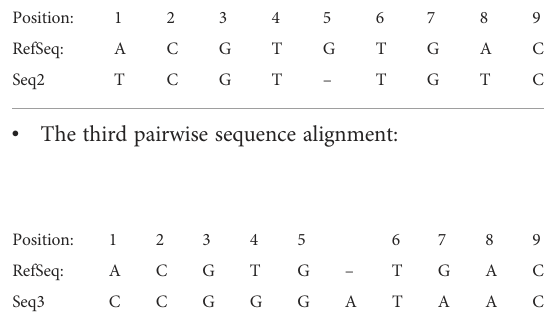
Figure 1B. There are 23803 unique mutations. A>G owns the highest ratio, C>G owns the lowest ratio (5.43%=1293/23803), and SARS-CoV-2 also has the lowest ratio of C>G (1.25%) (Wang et al., 2020).